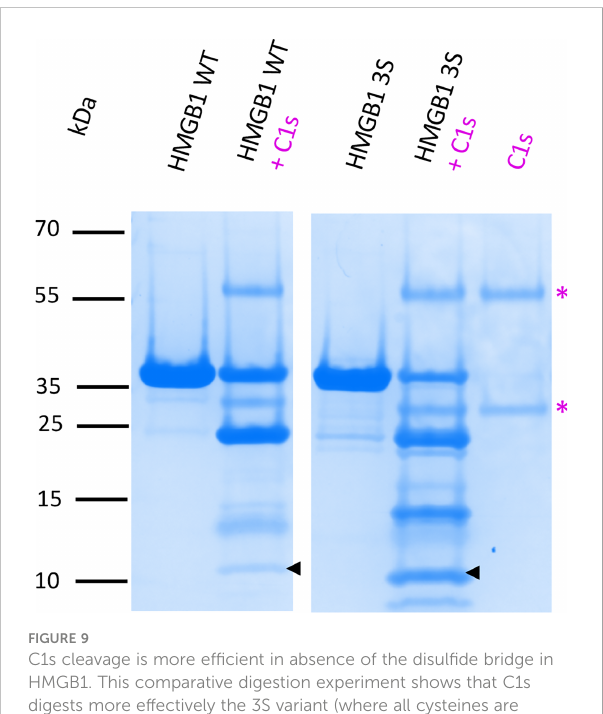
FIGURE 9 C1s cleavage is more ef fi cient in absence of the disul fi de bridge in HMGB1. This comparative digestion experiment shows that C1s digests more effectively the 3S variant (where all cysteines are replaced by a serine) than HMGB1. As shown by the arrows, more F3 fragment is released from C1s cleavage of the 3S variant. The 10- 20% Tricine gel shown for the C1s digestion is representative of two experiments. 5 m g HMGB1 or 3S were digested at 10% E/S for 90 min at 37°C. To consolidate the view of a more effective digestion of the 3S variant with more F3 released, a complementary experiment performed with increasing incubation times (from 1 to 7 h) is shown in Figure S5. * as in Figure 3.